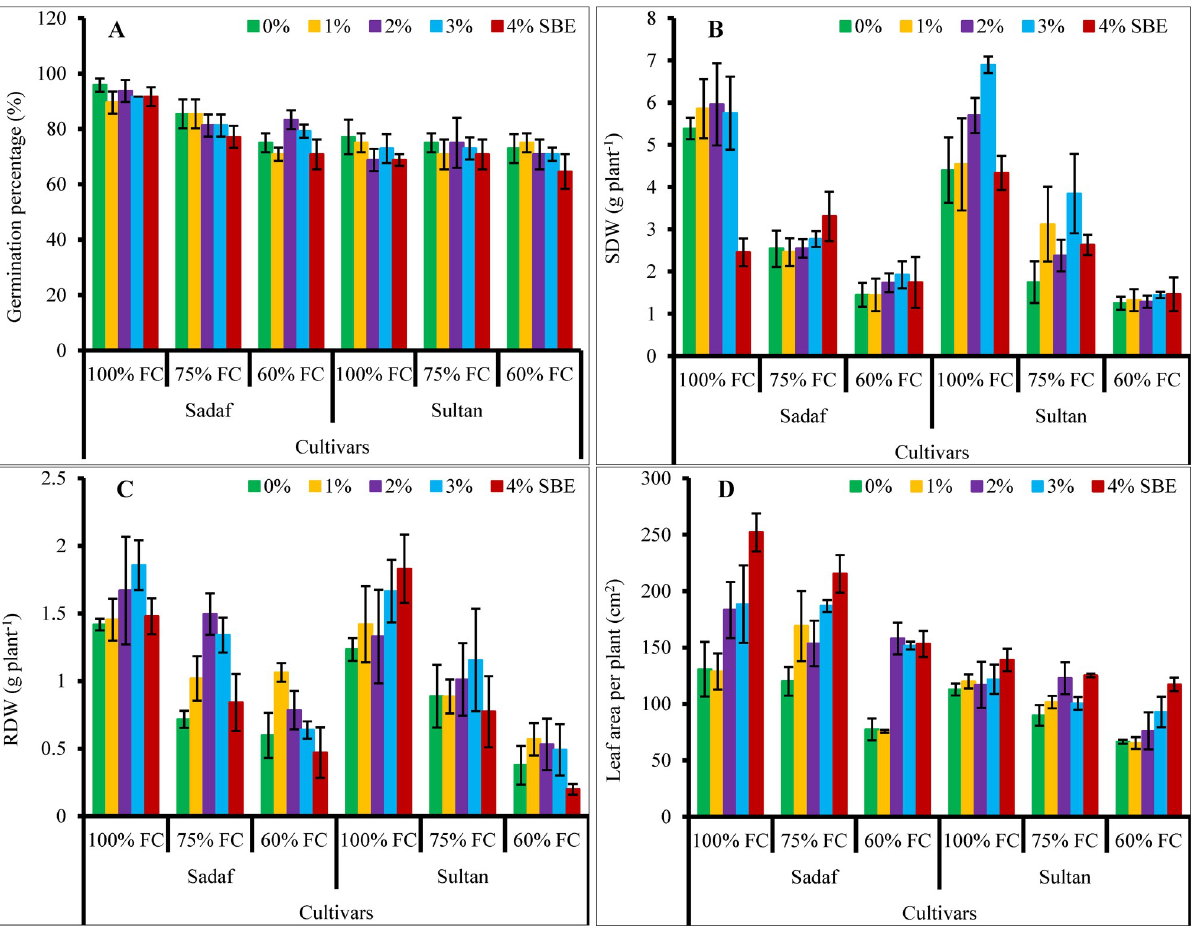
Fig 1. Effect of varying levels of sugar beet extract (SBE) on morphological attributes of maize plants subjected to water-deficit stress ( n = 3; Mean ± S.E.).